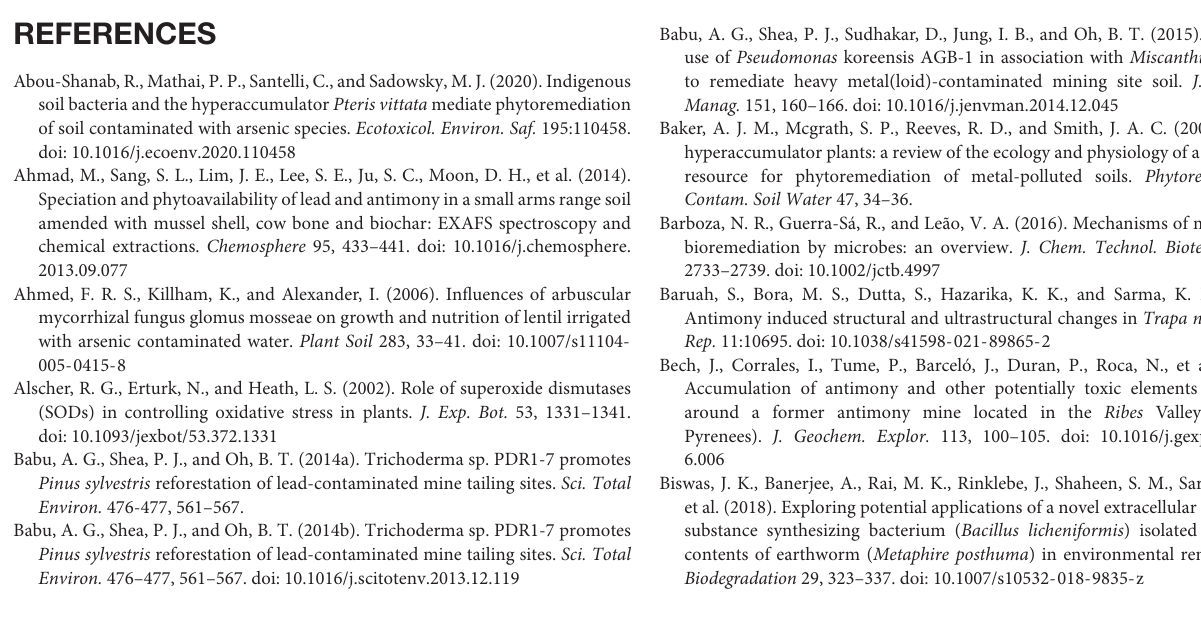
Supplementary Table 1 | Different antimony treatment for the experimental design. Supplementary Table 2 | Methods of physiological and biochemical experiments. Supplementary Table 3 | The BCF and TF of B. papyrifera under different